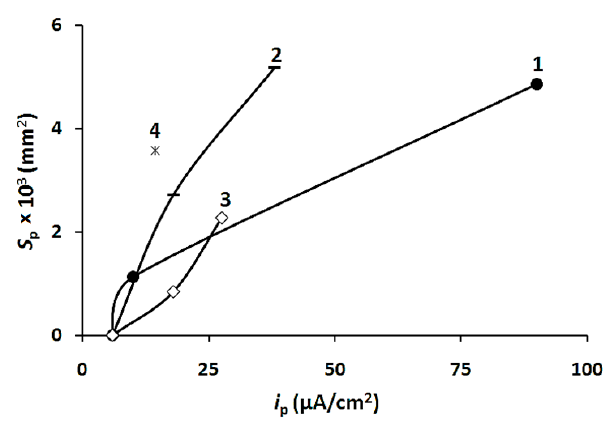
Figure 4. Correlation between the total pits area S p (duration of cathodic part of SACP 10 min and anodic part 3 min, total 72 cycles) and the hydrogen penetration current i p in solutions: 1 ( • ) BB, BB + NS4, BB + NS4 + TU; 2 (-) BB, BB + 0.1 M NaCl, BB + 0.6 M NaCl; 3 ( ♦ ) BB, BB + 0.1 M NaHCO 3 , BB + 0.1 M NaHCO 3 + TU; point 4 ( ∗ ) is non-buffered 0.1 M NaCl aqueous electrolyte.